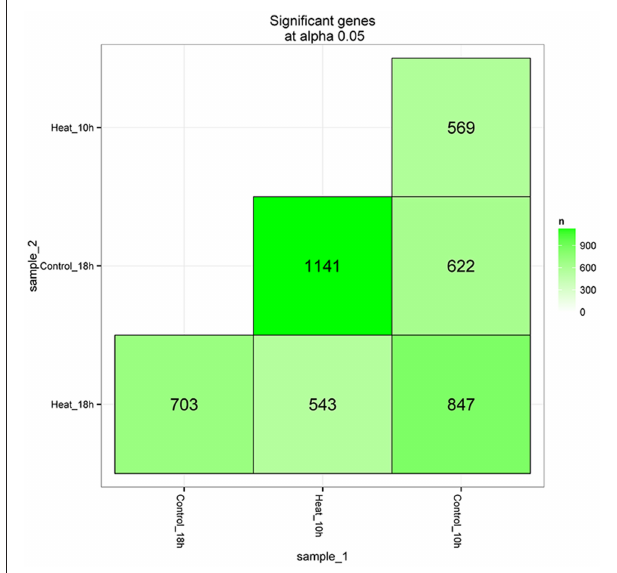
FIGURE 3 | The matrix of differentially expressed genes between any two groups (Control_10h, Heat_10h, Control_18h, and Heat_18h) of coral Galaxea fascicularis